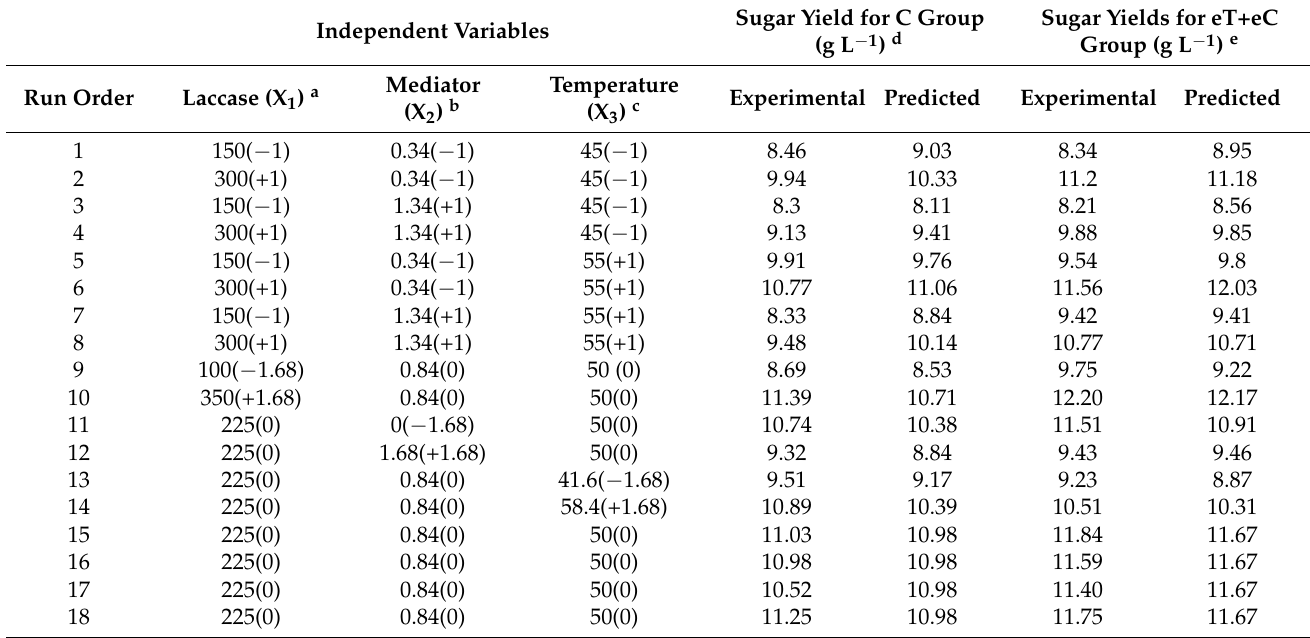
Table 5. Experimental design (conditions and responses) for crude laccase pretreatment of Panicum maximum biomass. Sugar Yield for C Independent Variables